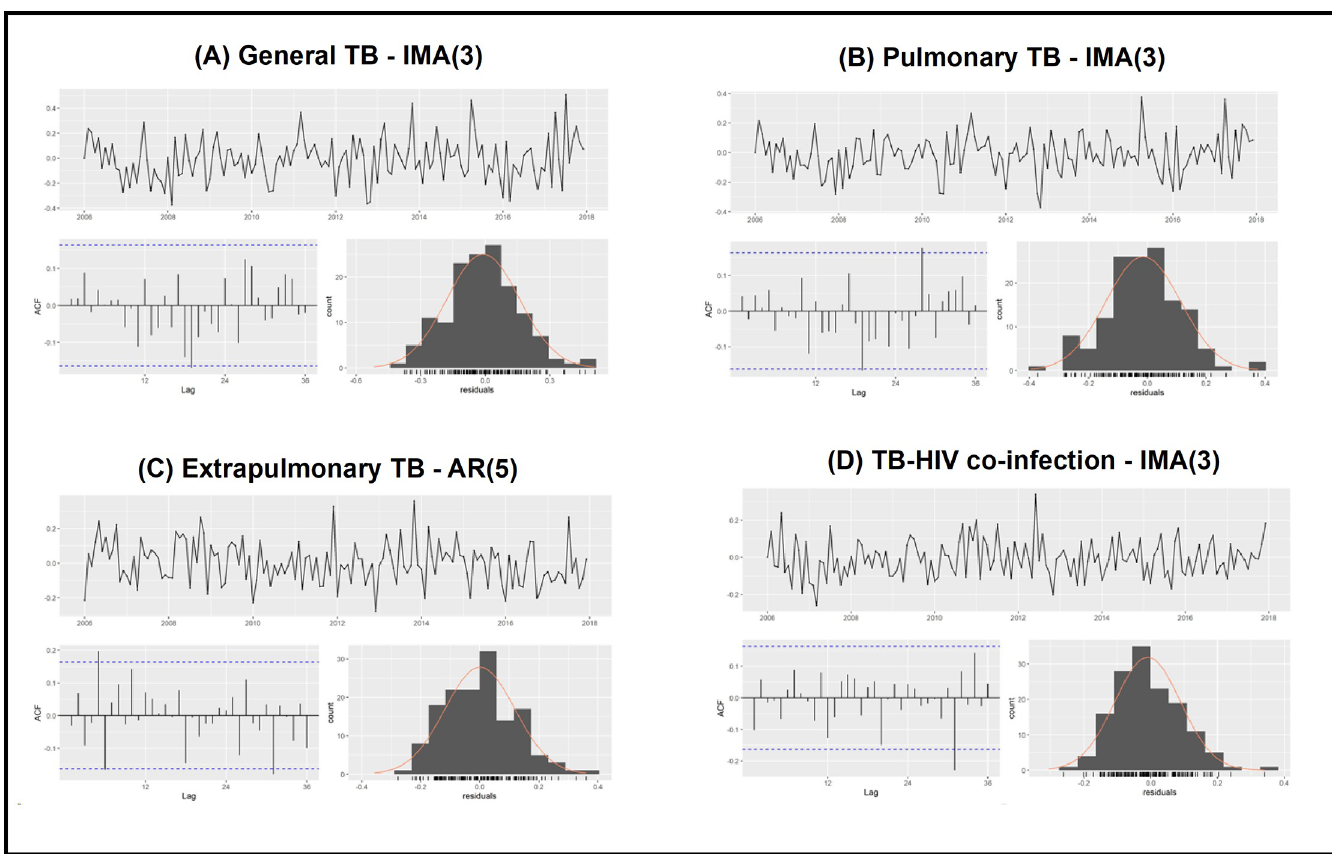
Fig 3. Residue analysis (schedule, ACF and histogram) of the models estimated for the tuberculosis rates, Ribeir ã o Preto, S ã o Paulo, Brazil, 2006–2017.